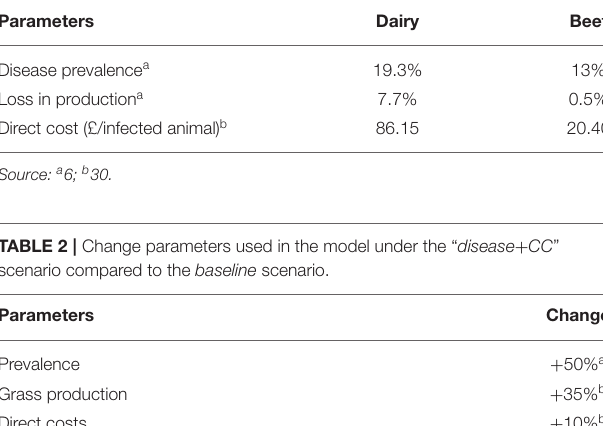
TABLE 1 | Disease parameters used in the model.